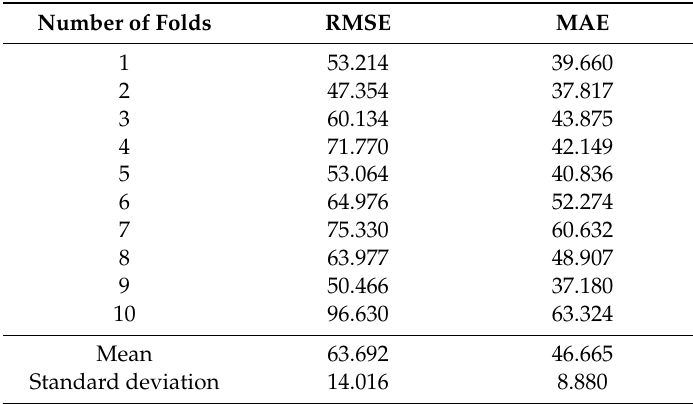
Table 4. The results of the 10-fold cross-validation.